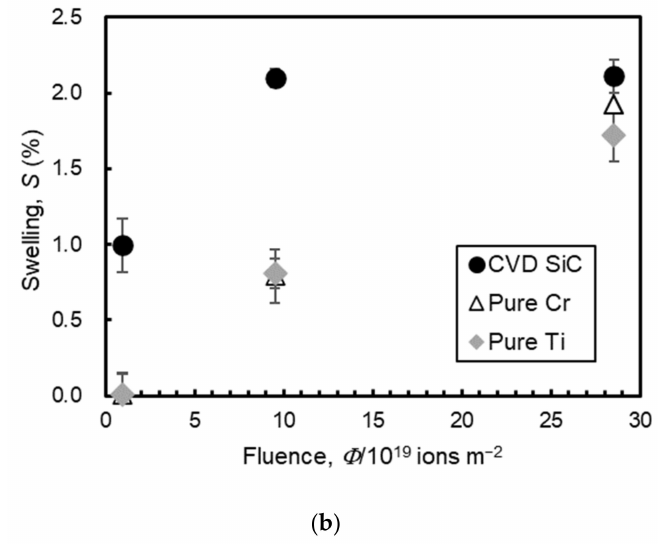
Figure 4. Changes in ( a ) height step and ( b ) swelling of pure Ti, pure Cr and CVD SiC after irradiation with 5.1 MeV Si 2+ ions up to a fluence of 2.85 × 10 20 ions/m 2 .